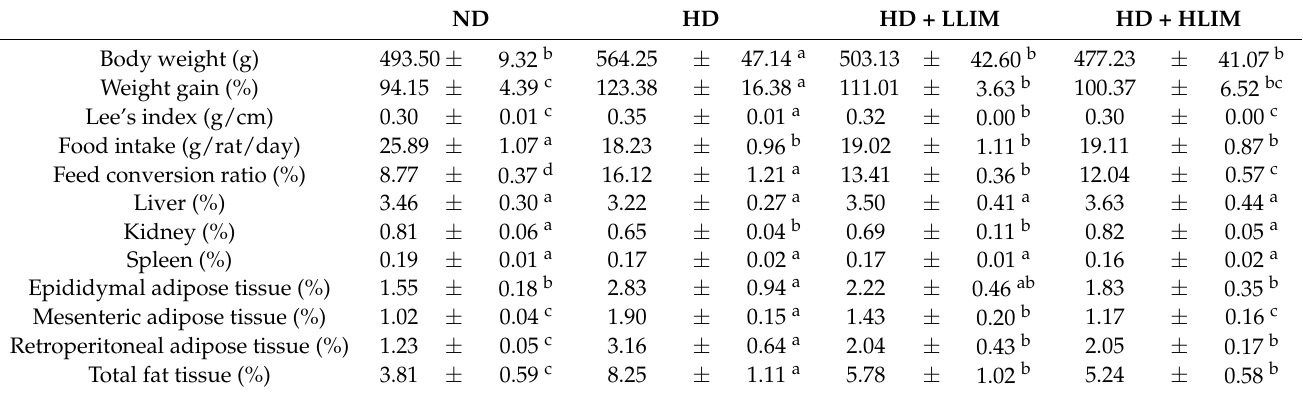
Table 1. Effect of limonene (LIM) on the growth characteristics in high-calorie diet-induced obese rats. ND HD HD +